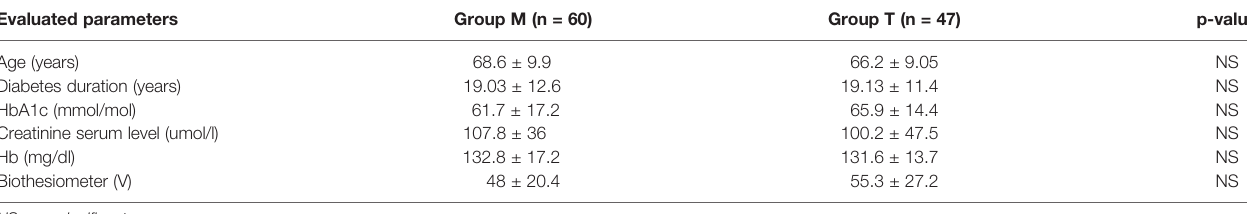
TABLE 1 | Comparison of basal characteristics between study groups. Evaluated parameters